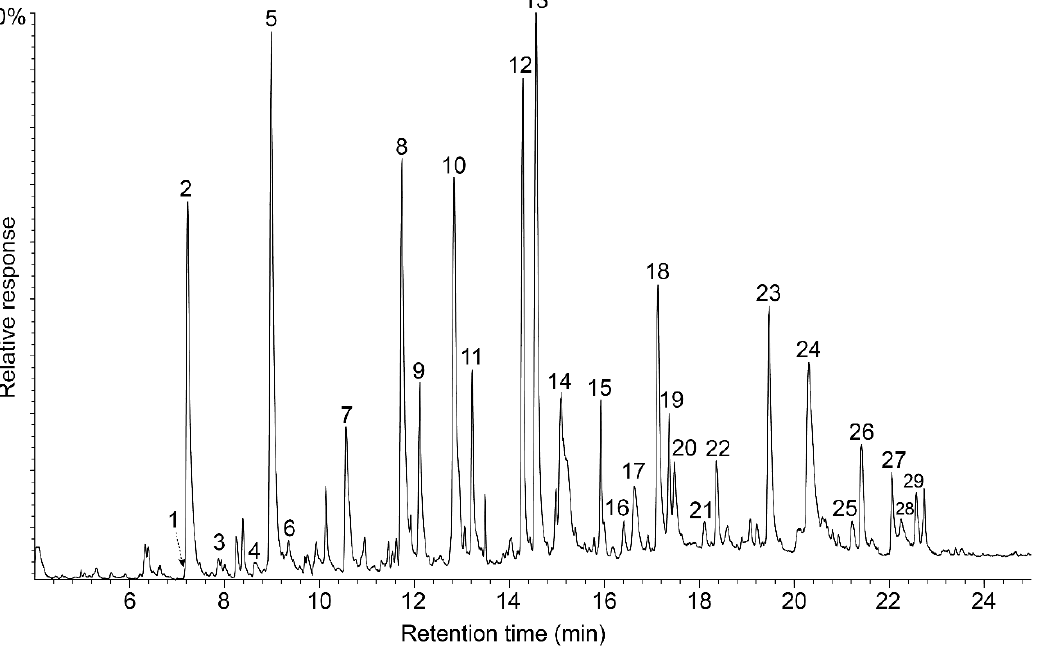
Figure 1. Py-CG/MS of the OTP-MWL. The identities and relative abundances of the released numbered compounds are listed in Table 2.